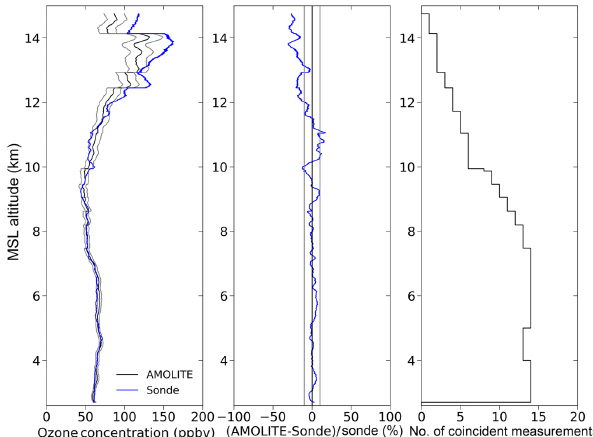
Figure 6. Three-panel plot showing the average of all AMOLITE and coincident sonde profiles throughout the entire SCOOP cam- paign. The number of coincident measurements varies with altitude primarily due to the reduced altitude capability of the AMOLITE during daytime